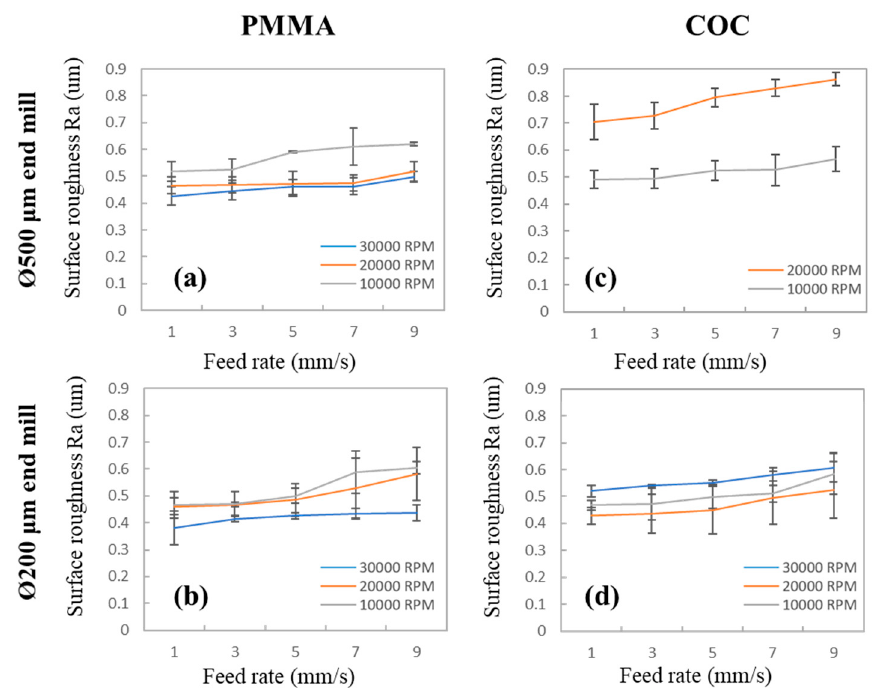
Figure 2. Surface roughness of polymethyl methacrylate (PMMA) ( a , b ) and cyclic olefin copolymer (COC) ( c , d ) after milling at di ff erent feed rates, spin speeds, and end mill diameters. Error bars were obtained based on three individual measurements.